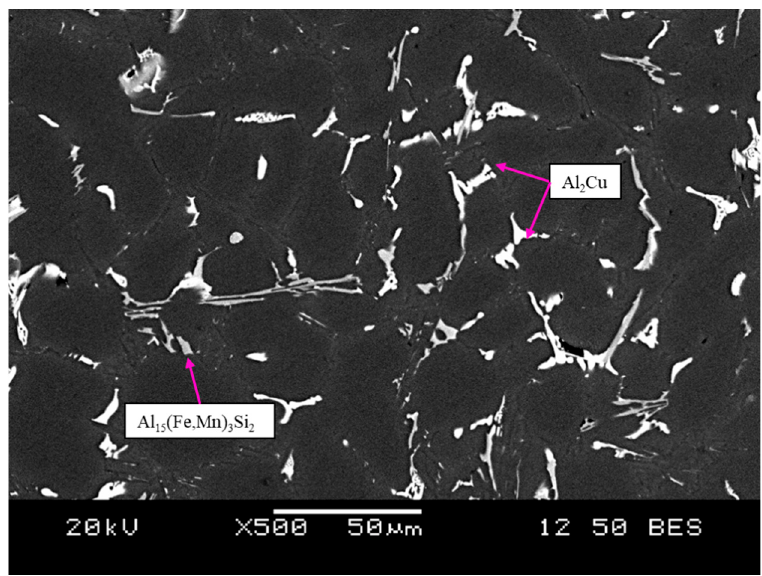
Figure 2. Backscattered SEM image of A319 + 0.05 GNP + SS + UST microstructure at 500×.